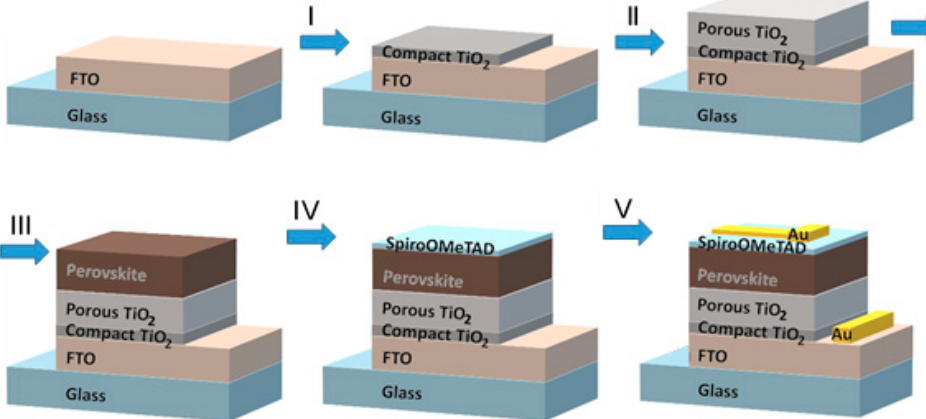
Figure 1. Schematic step-like representation of the perovskite solar cell formation. During step I, a ~30 nm-thick compact TiO 2 (Greatcell Solar Italia S.R.L., Italy) layer